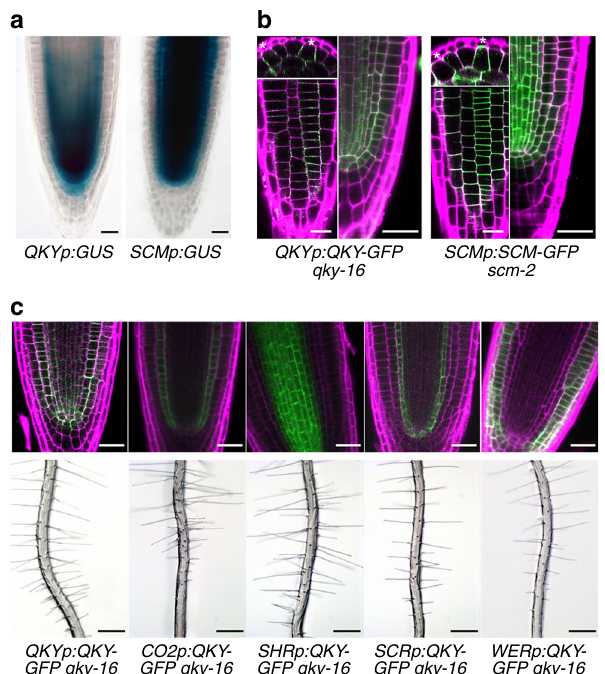
Fig. 1 Expression pattern and tissue-autonomous function of QKY gene in the root. a The promoter activity of QKY ( QKYp:GUS) and SCM ( SCMp:GUS ) in the developing root of 4-day-old seedlings. Bar = 25 μ m. b Localization of QKY and SCM in the developing root meristem. Four-day-old seedlings bearing QKYp:QKY-GFP and SCMp:SCM-GFP translational fusions (left top, transverse section; left bottom, surface view; right, median longitudinal section) were stained with propidium iodide (magenta) and analyzed for GFP accumulation (green). The photos for each view were taken at a similar location in the root, respectively. Asterisks indicate the H-position cells. Bar = 25 μ m. c Tissue-speci fi c expression of QKY-GFP in qky-16 mutant. Four-day-old seedlings of qky-16 plants harboring different complementation constructs were stained with propidium iodide (magenta) and analyzed for QKY-GFP accumulation (green) (top; bar = 25 μ m). Root hair phenotype of qky-16 seedlings harboring different complementation constructs (bottom; bar = 250 μ